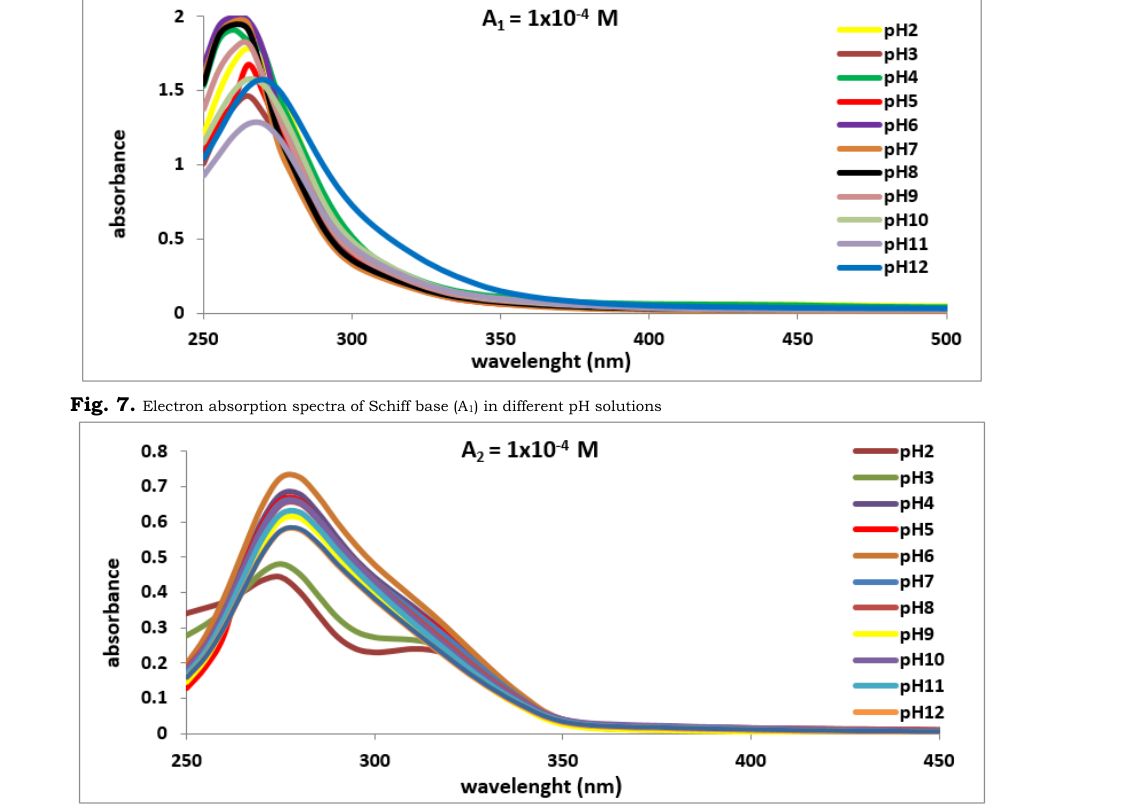
Fig. 8. Electron absorption spectra of Schiff base (A 2 ) in different pH